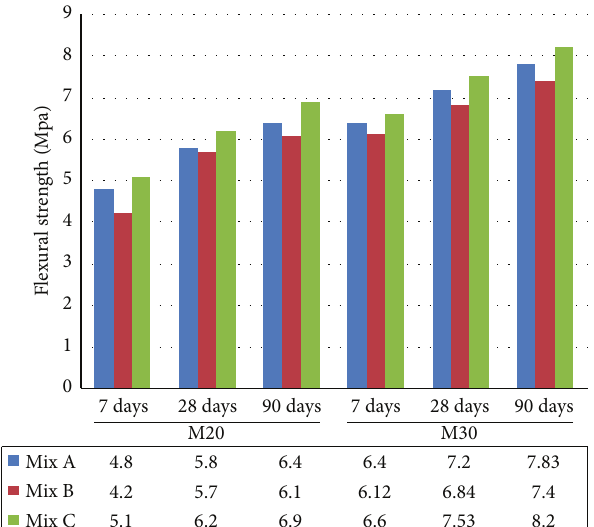
Figure 8: Comparative flexural strength of Mix A, Mix B, and Mix C of M20 and M30 grade.